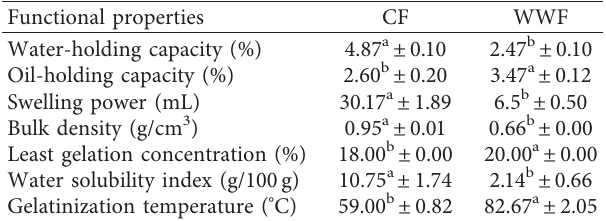
Table 2: Functional properties of cladode flour and whole-wheat flour. Functional properties